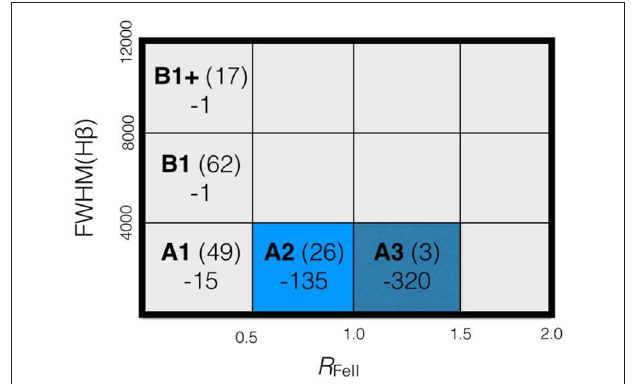
FIGURE 5 | Average shift of [O III ] λ 5007 (negative is blueshift) for spectral types in the optical plane of 4DE1. Numbers in parentheses indicate sources in each bin with the dataset available to us in late